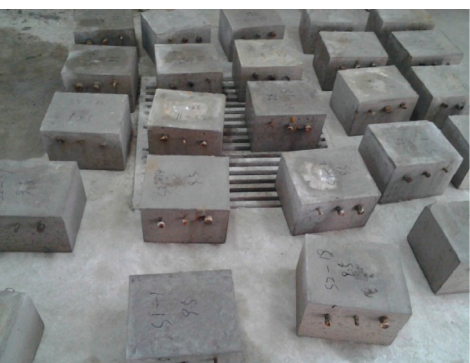
Figure 4: The formed reinforced concrete